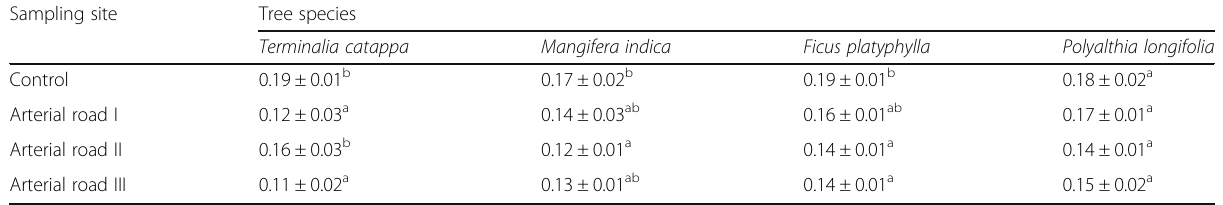
Table 8 The effect of vehicular air pollution on of carotenoids (mg/g) contents of selected tree species in the Kumasi Metropolis Sampling